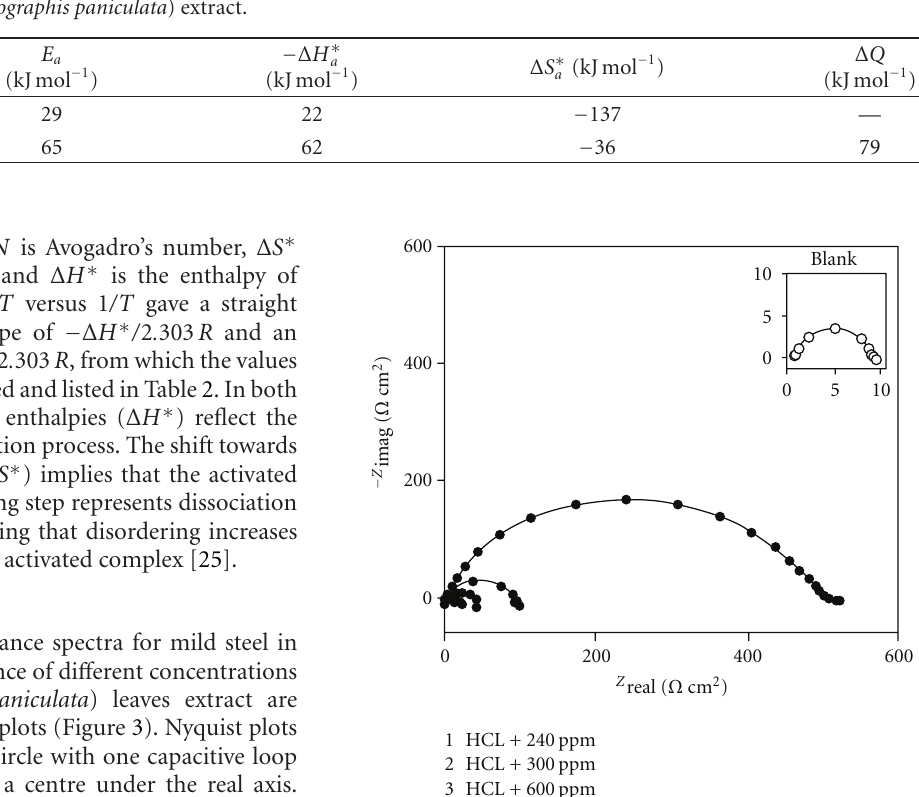
Table 2: The values of activation parameters E a , Δ H ∗ a , and Δ S ∗ a for mild steel in 1 M HCl in the absence and presence of optimum concentrations of Kalmegh ( Andrographis paniculata ) extract.